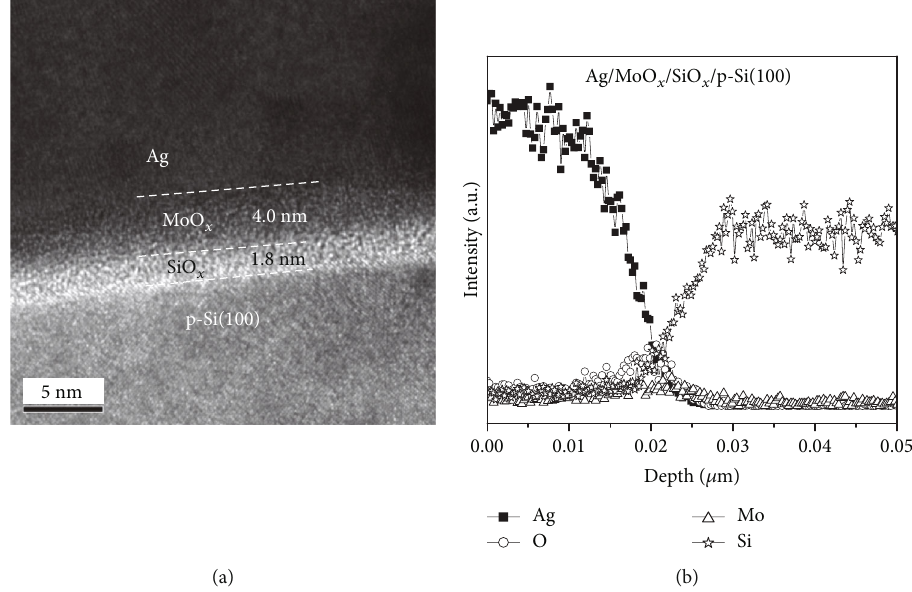
fi lms with H /Ar PPT. x /Ag stacked 2 Ag/n + -Si/p-Si(100)/SiO x /MoO x /Ag H 2 /(H 2 + Ar) = 22.2 % Temperature = 250 C Pressure = 200 mTorr Frequency = 13.5 MHz